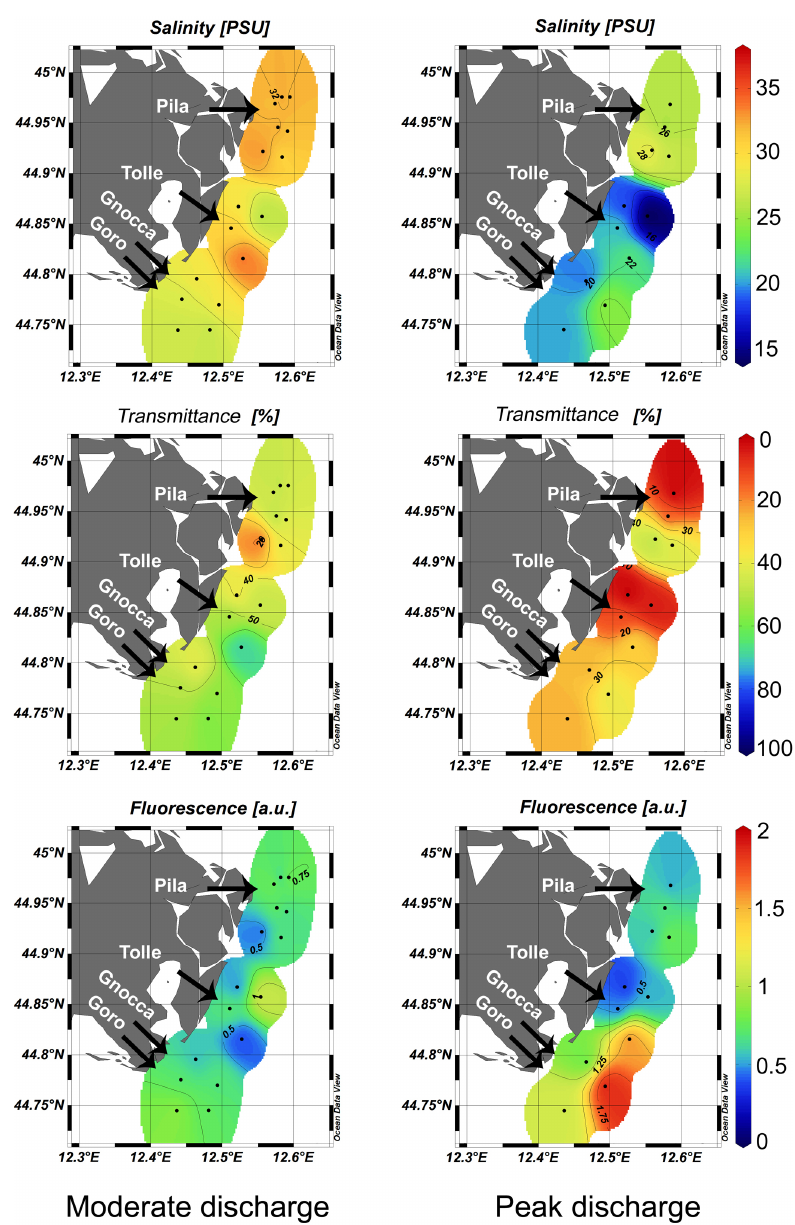
Fig. 4. Salinity, transmittance, and fluorescence in the Po prodelta in surface waters (1m below the sea surface) during moderate ( ∼ 5000m 3 s − 1 ) and peak discharge ( ∼ 8000m 3 s − 1 )